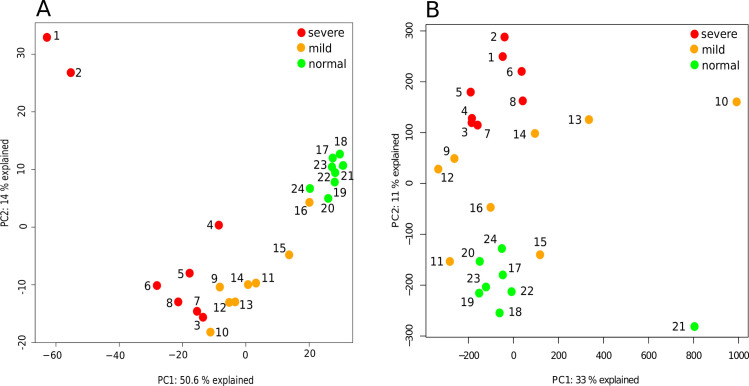
Principal component analysis (PCA).(A) PCA of gene expression data of the thousand most variable genes (transPCA). Unsupervised PCA analysis presenting the difference between severe UC (red, n = 8), mild UC (orange, n = 8) and control (green, n = 8). The first two components explain 51% and 13.5% of the variability in the gene expression data. (B) PCA depicting the global methylation (methPCA) of relative methylation counts (0–100%) for over 9 million cytosine positions including normal (green, n = 8), treatment-naïve mild UC (orange, n = 8) and severe UC (red, n = 8) patient tissue samples. The first two components explain 33% and 11% of the variability in the methylation data.